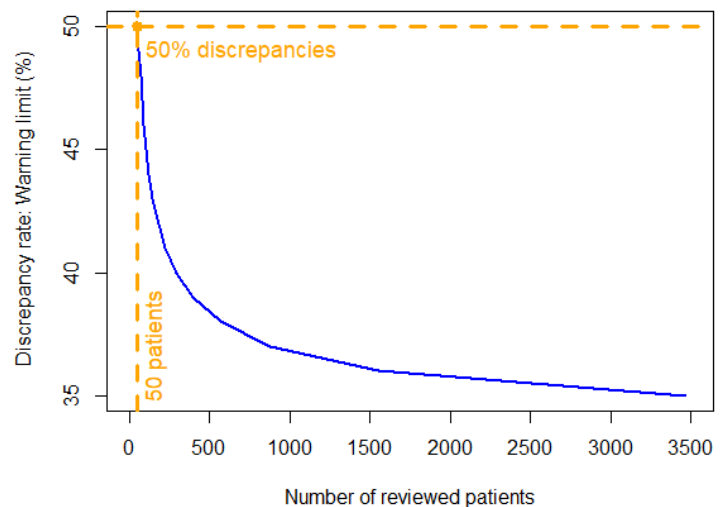
Figure 2. Warning limit for monitoring the discrepancy rate in the DOP. Limit of acceptable discrepancy rate measured as a function of the number of patients read in the trial. In orange: a discrepancy rate higher than 50% after reviewing more than 50 patients warns of suboptimal performances in the